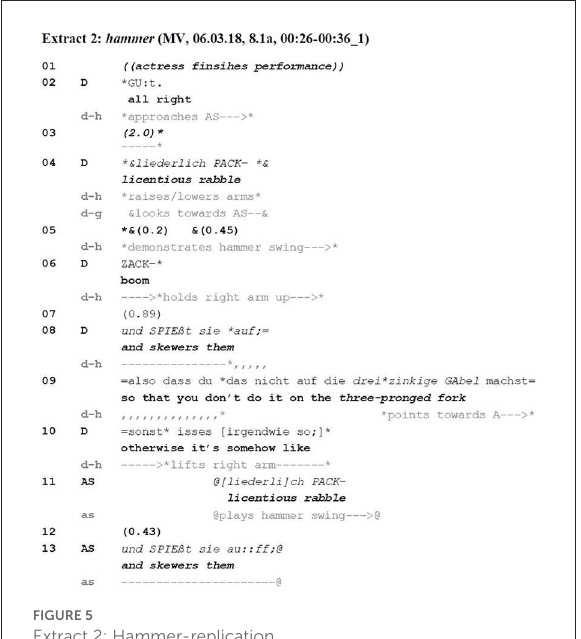
FIGURE5 Extract 2: